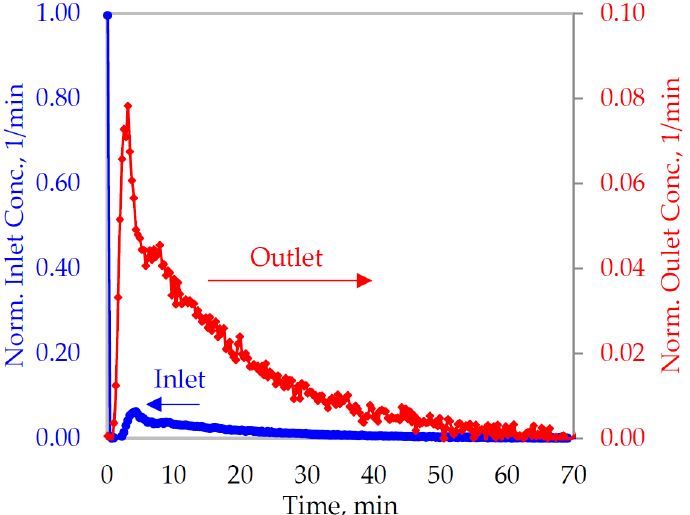
Figure 2. Example of normalized inlet and outlet tracer concentrations of solids in the ball mill BM1. Continuous lines added for visualization purposes only.